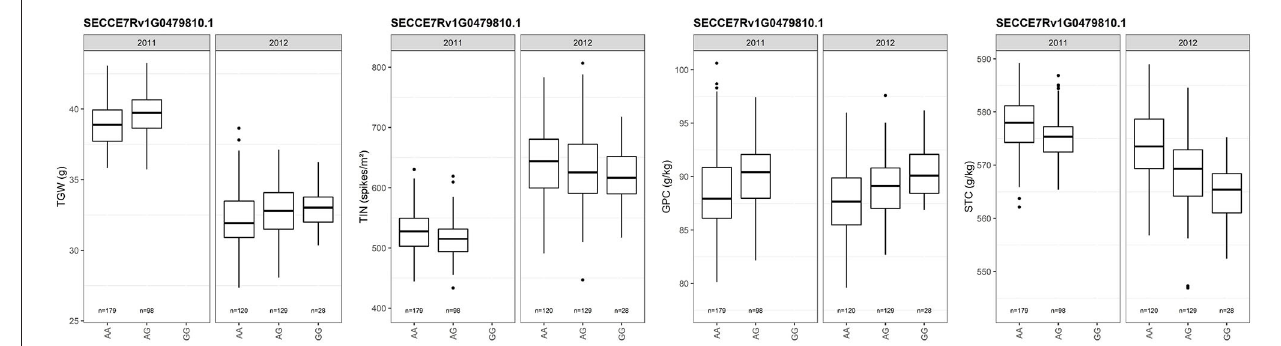
FIGURE 10 | Box plots depicting the effect of SNP genotypes of the ETHYLENE OVERPRODUCER 1-like gene SECCE7Rv1G0479810 on TGW, TIN, GPC and STC in rye. Dots represent outliers. TGW, thousand-grain weight; TIN, tiller number; GPC, grain protein content; STC, starch